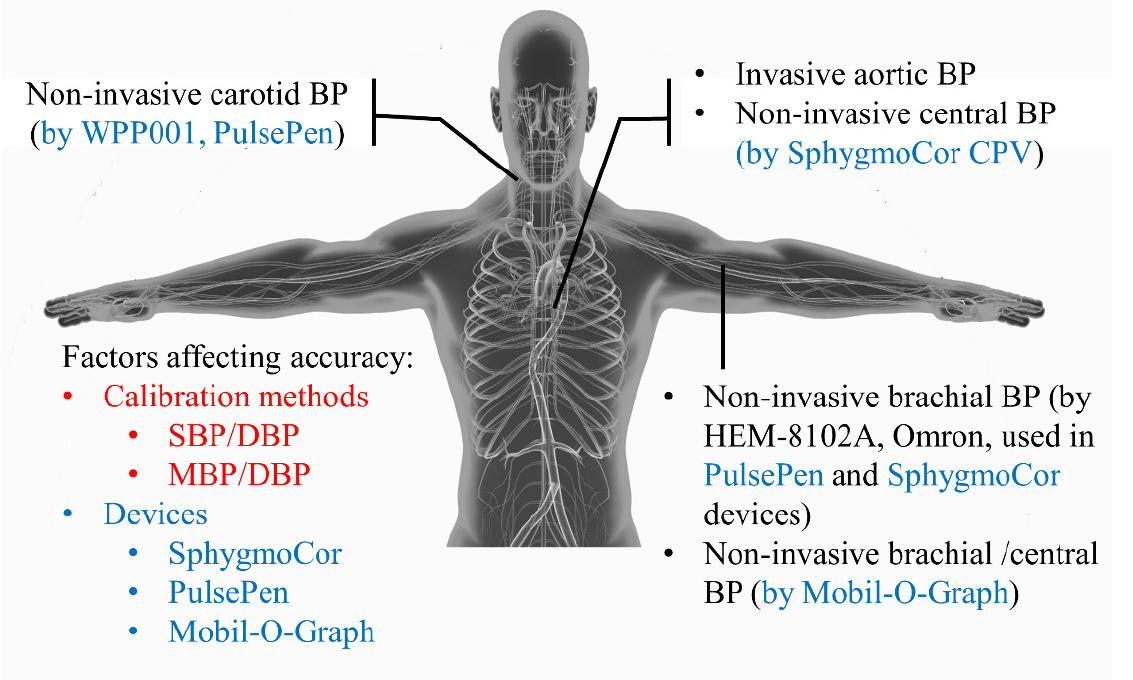
Figure 1. Study design. Factors (calibration methods and devices) that may impact the noninvasive measurement accuracy of central blood pressure are shown in red and blue, respectively. BP: blood pressure. SBP: systolic BP. DBP: diastolic BP. MBP: mean BP.